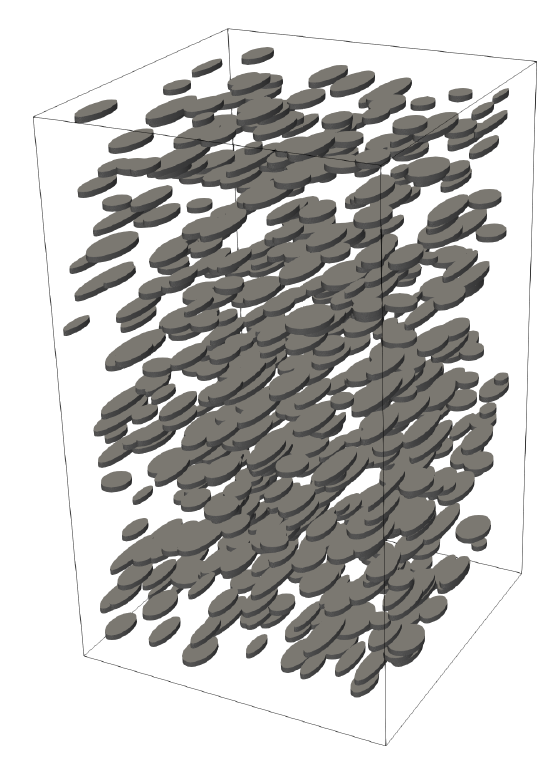
Figure 3. Randomly distributed elliptical flow barriers in the otherwise homogeneous 3D